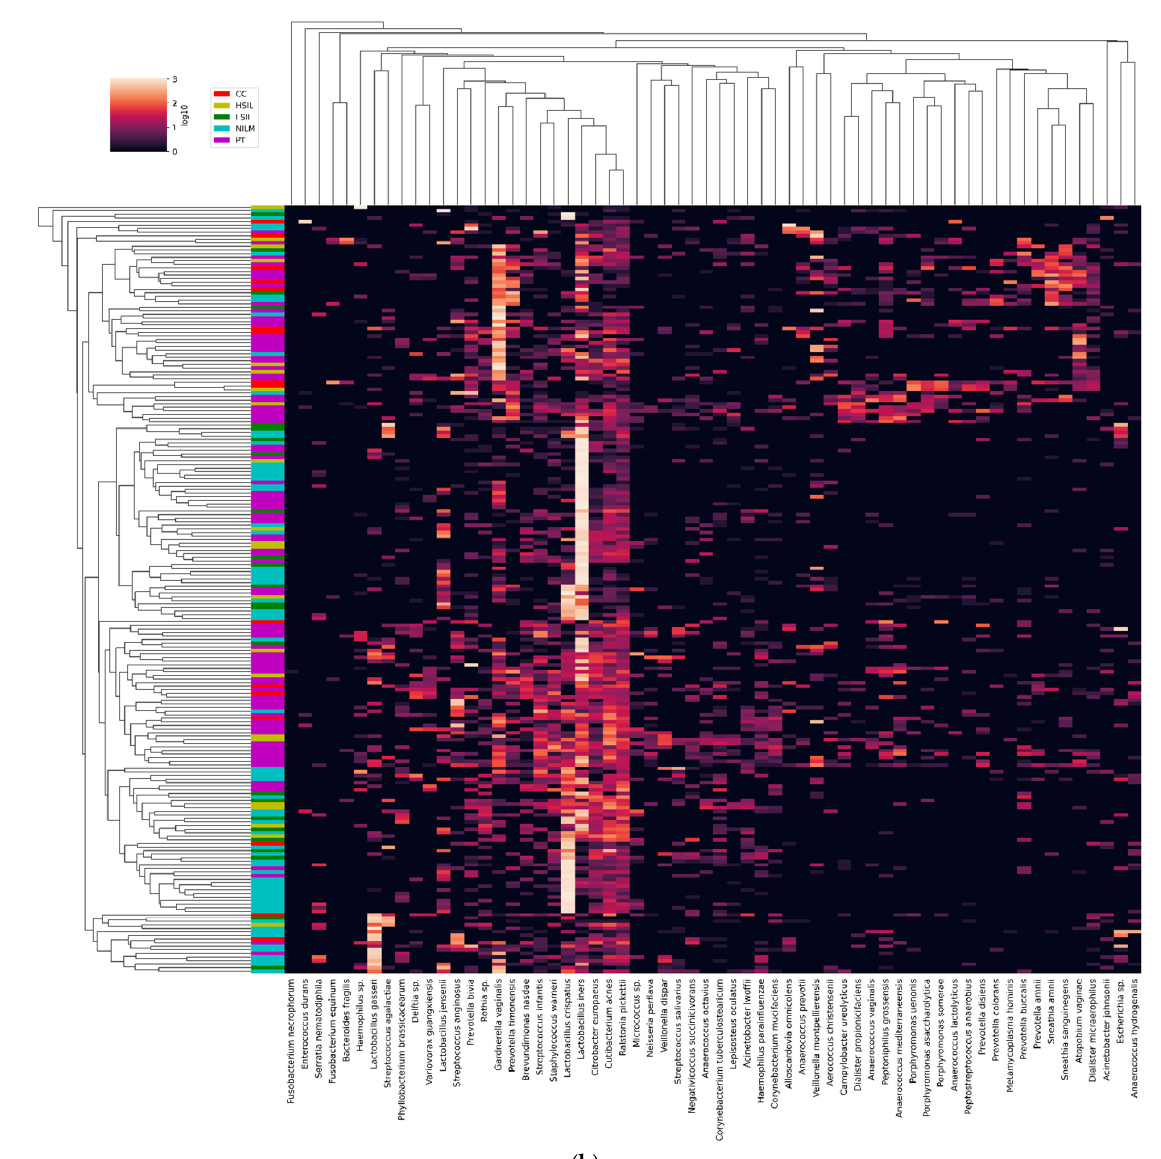
Figure 4. Community composition of cervical samples at the level of families ( a ) or species ( b ) as determined by massively parallel sequencing on the MiSeq platform. An unsupervised heatmap of the relative abundance of microbial taxa found in the cervicovaginal microbial communities of 234 patients: 72 NILMs (5 samples were excluded for technical reasons), 24 LSILs, 22 HSILs (2 samples were excluded for technical reasons), 15 СС s (1 sample was excluded for technical reasons), 101 PT samples, based on the Bray–Curtis dissimilarity metric. Diagnoses of patients are indicated by col- ors. ( a ) The families present in relative abundance of 1% in at least one sample are listed on the X axis. ( b ) Top 62 species (by abundance) are listed on the X axis. The cladograms at the top of the species’ and families’ names indicate the approximate evolutionary relationships between the spe- cies. LB species analysis by 16S metagenome sequencing. ( a ) The enrichment with lactobacilli (rela- tive proportion of reads mapped to genomes of Lactobacillus spp.) at different diagnoses and post- treatment.